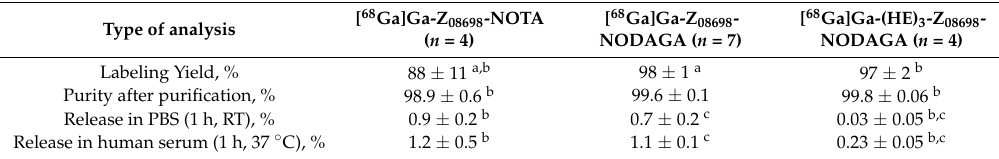
Table 1. Labeling and in vitro stability. Average radiochemical yield ( n = 4–7) and purity of conjugates after NAP5 size-exclusion purification. To test stability, 2 µ g of the purified conjugates was incubated for 1 h in PBS orhuman serum. Stability is presented as % release.